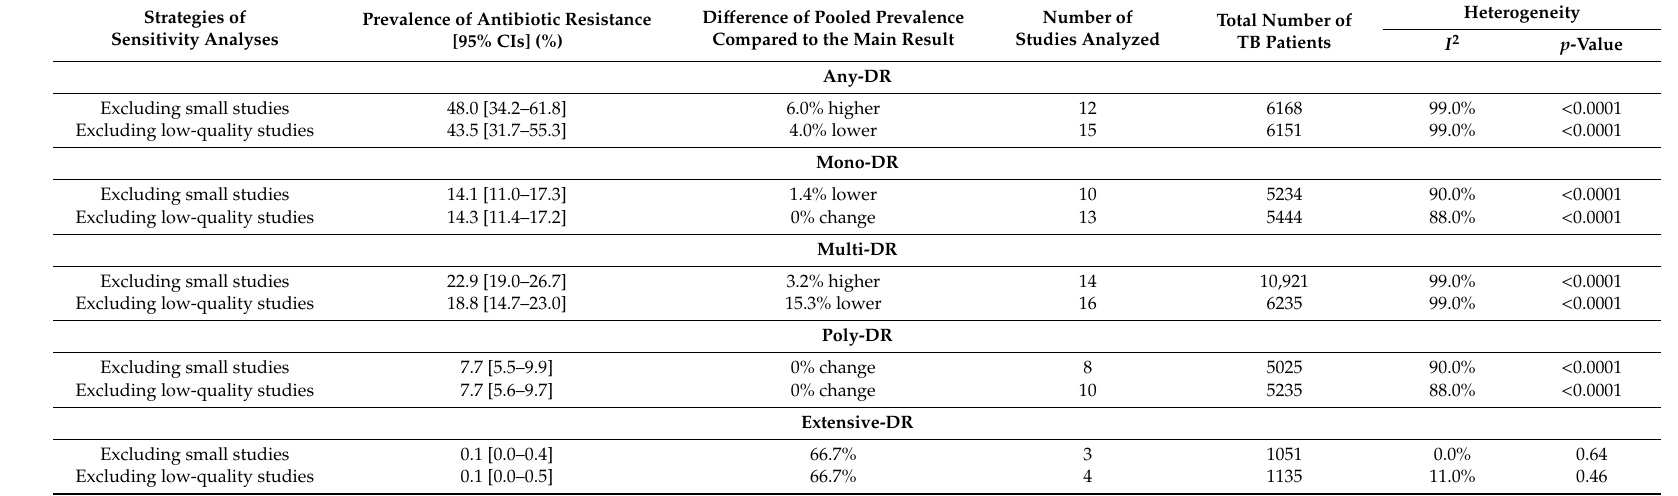
Table 4. Sensitivity